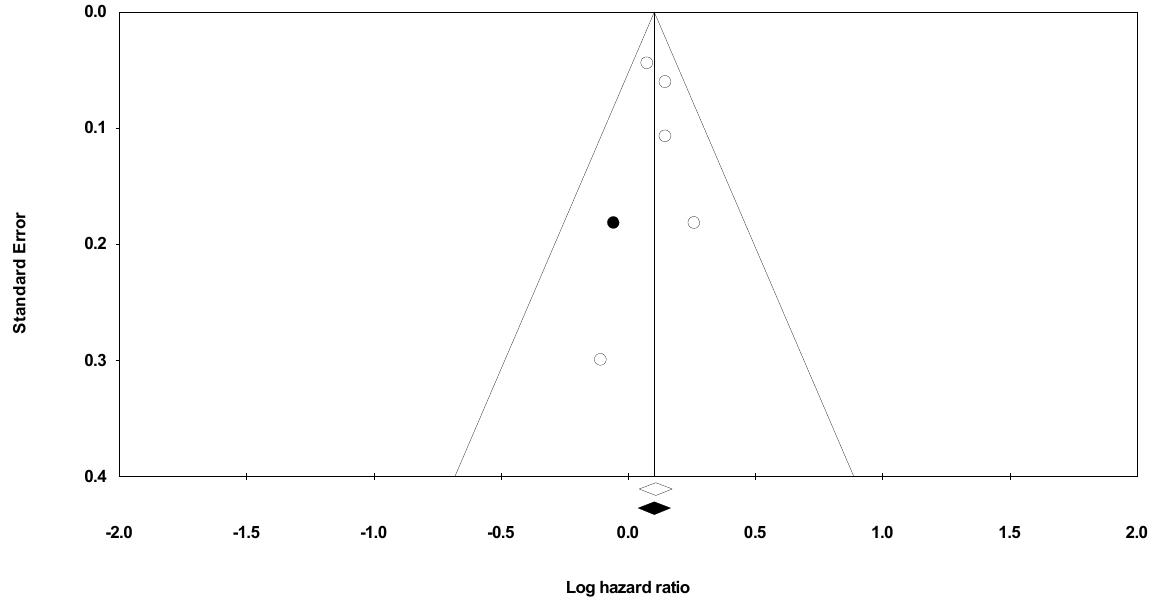
Figure 7. Funnel plot of the observed and plotted studies for assessing the association between HAP and cerebrovascular accidents after using the trim and fill method of Duvall and Tweedie. The white circles represent the observed studies, and the black circles represent the plotted